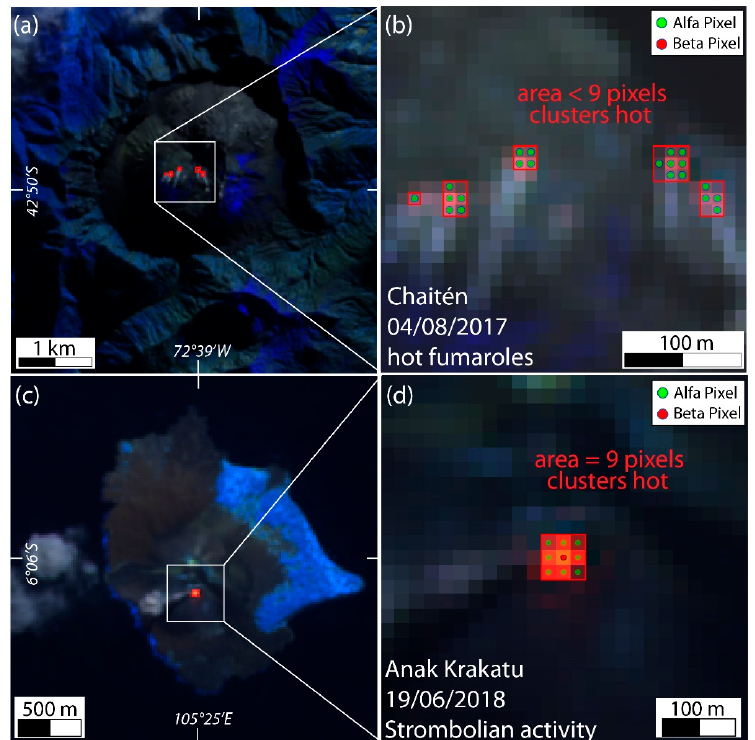
Figure 4. Nine pixels threshold. ( a ) Algorithm application on Chaitén volcano, the 04/08/2017; ( b ) red boxes represent the bounding box of each alerted cluster and isolated the hot fumaroles; ( c ) algorithm application on Anak Krakatau volcano, 19/06/2018; ( d ) red box represent the bounding box of the alerted cluster and isolated the hot-spot pixels related to strombolian activity. With green and red dots, hot pixels triggered by α and β conditions, respectively. Remote Sens. 2020 , 12 , x FOR PEER REVIEW